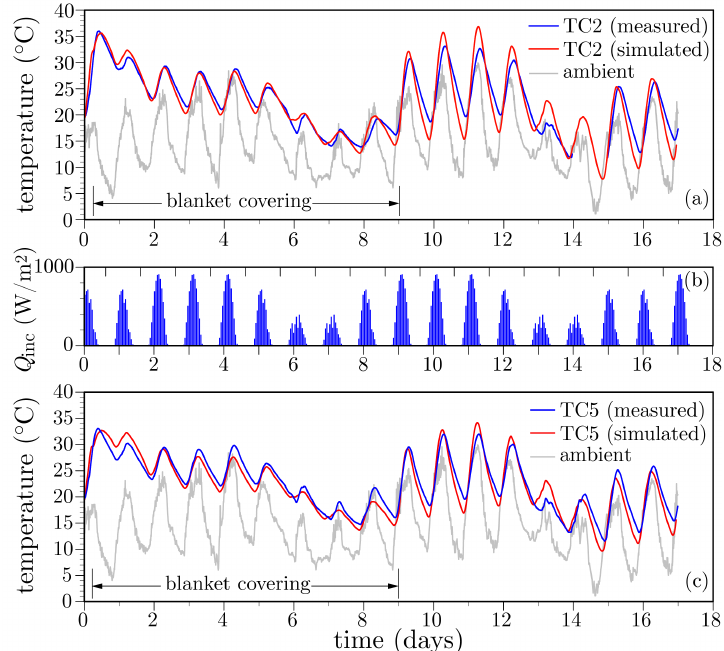
Figure 16. Temperature variation within the Markham Ravine Bridge deck: ( a ) mid-deck at location